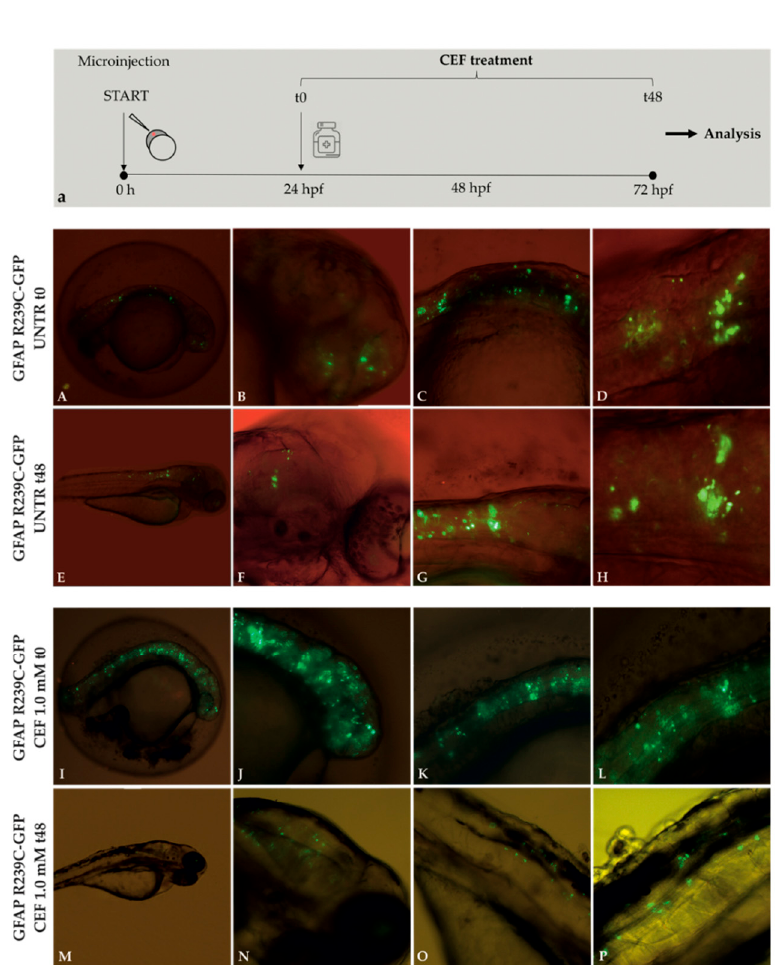
Figure 6. Experimental plan showing the timeline of ceftriaxone (CEF) treatments and the effects of 48 h CEF 1.0 mM treatment on embryos expressing GFAP R239C-GFP. ( a ). The antibiotic ceftriaxone was added 24 h after eggs microinjection. This moment was defined as “time zero” (t0). Fluorescence microscope analysis. Aggregates in untreated (UNTR) embryos are shown in figure ( A – D ) at 24 hpf (t0) and from ( E – H ) at 72 hpf (t48), corresponding to the start and end points of CEF treatment. Figure ( I – L ) show aggregates at 24 hpf (t0), while figure ( M – P ) show aggregates at 72 hpf (t48), after 48 h of treatment with CEF 1.0 mM. Magnification: 4 × ( A , E , I , M ); 10 × ( B , C , F , G , J , K , N , O ); 20 × ( D , H , L , P